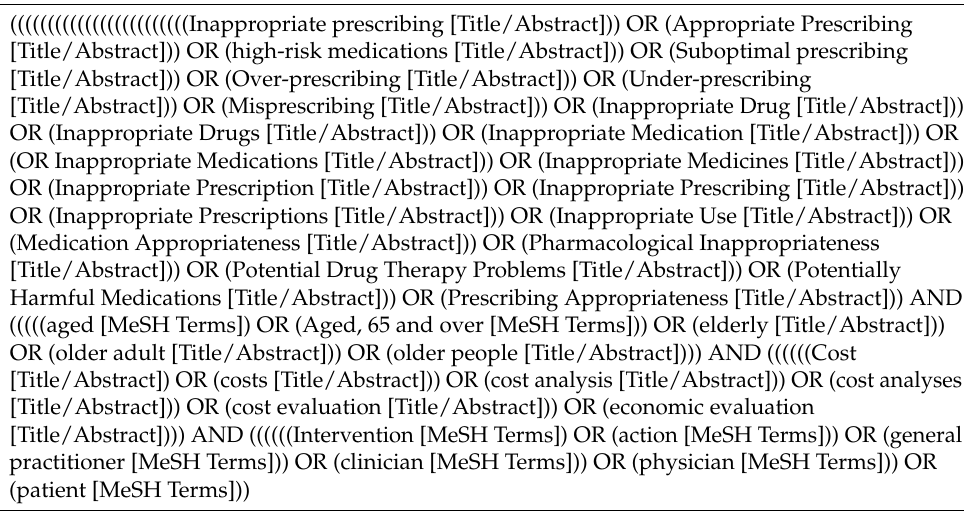
Table A1. Full search strategy. Search Strategy Performed in